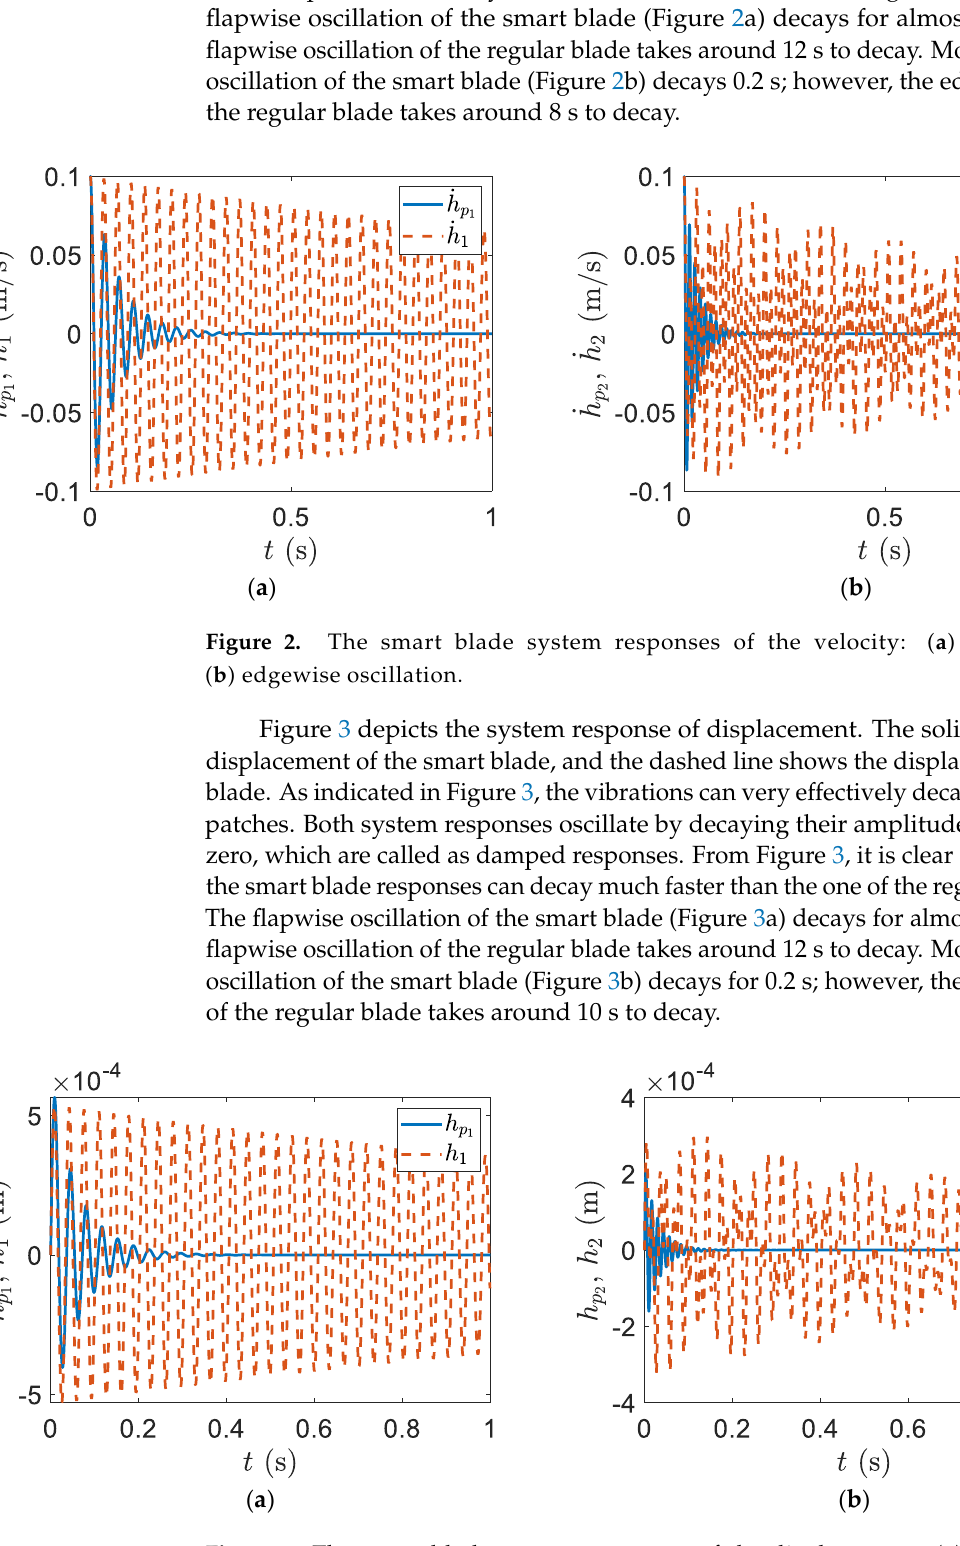
( b ) Figure 4. Phase plane for the velocity and the displacement: ( a ) flapwise trajectory; ( b ) edgewise trajectory. Likewise, the electrical current and the charge phase plane start at the electrical cur- rent and charge initial conditions which are zeros, and they turn out counter-clockwise until arriving at the maximum values. The trajectories then turn towards the start point (0,0) , as shown in Figure 5.